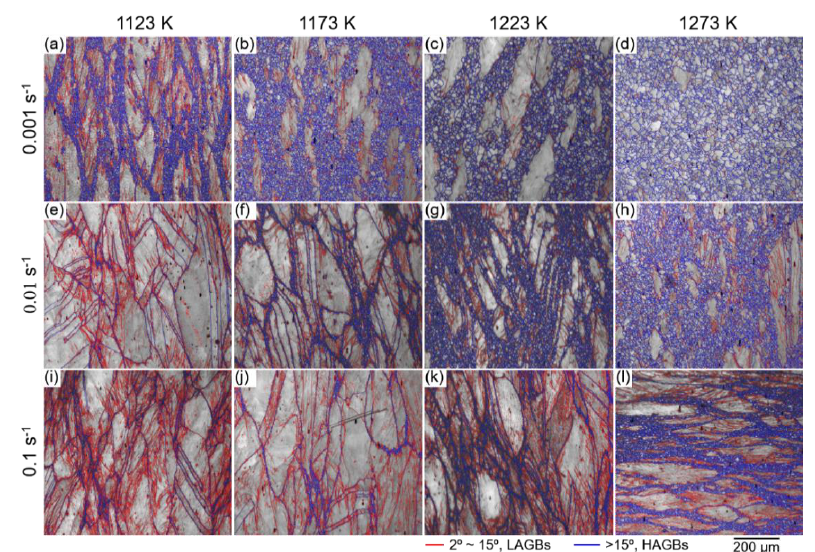
Figure 7. EBSD IQ maps of the Co 35 Cr 25 Mn 15 Ni 15 Fe 10 TRIP-HEA hot-compressed at ( a , e , i ) 1123 K, ( b , f , j ) 1173 K, ( c , g , k ) 1223 K, and ( d , h , l ) 1273 K with strain rates of ( a – d ) 0.001 s −1 , ( e – h ) 0.01 s −1 , and ( i – l ) 0.1 s −1 ,